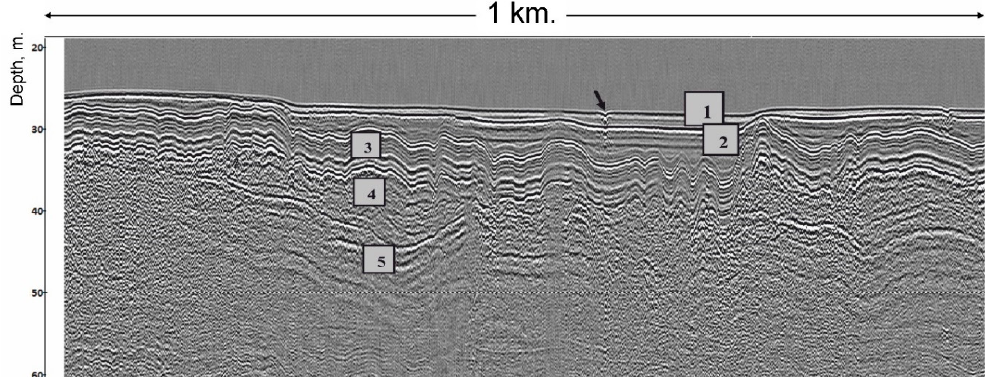
Figure 2. Seismic stratigraphic structure of sediments in the Petrozavodsk Bay (the position, see Figure 1). Legend: (1) lacustrine sediments of the Middle and Upper Holocene (lH 2–3 ); (2) lacustrine sediments of the Lower Holocene (lH 1 ); (3) limno-glacial sediments (varved clays) of the Late Pleistocene (the Valday (Weichselian) Glacial stage) (lgIII); (4) glacial sediments (till) of the Late Pleistocene (Valday Glacial stage) (gIII); 5: bedrock. The arrow indicates the location of a pockmark.